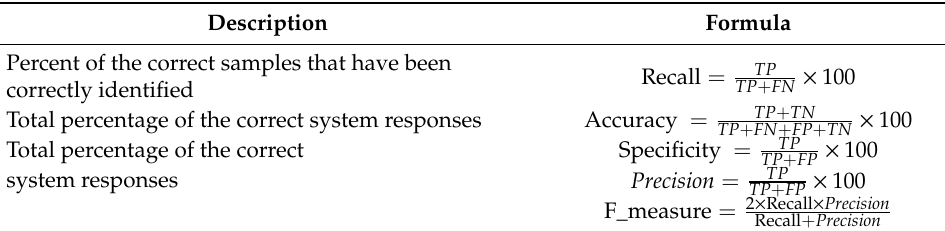
Table 3. Description of the classifiers used in performance